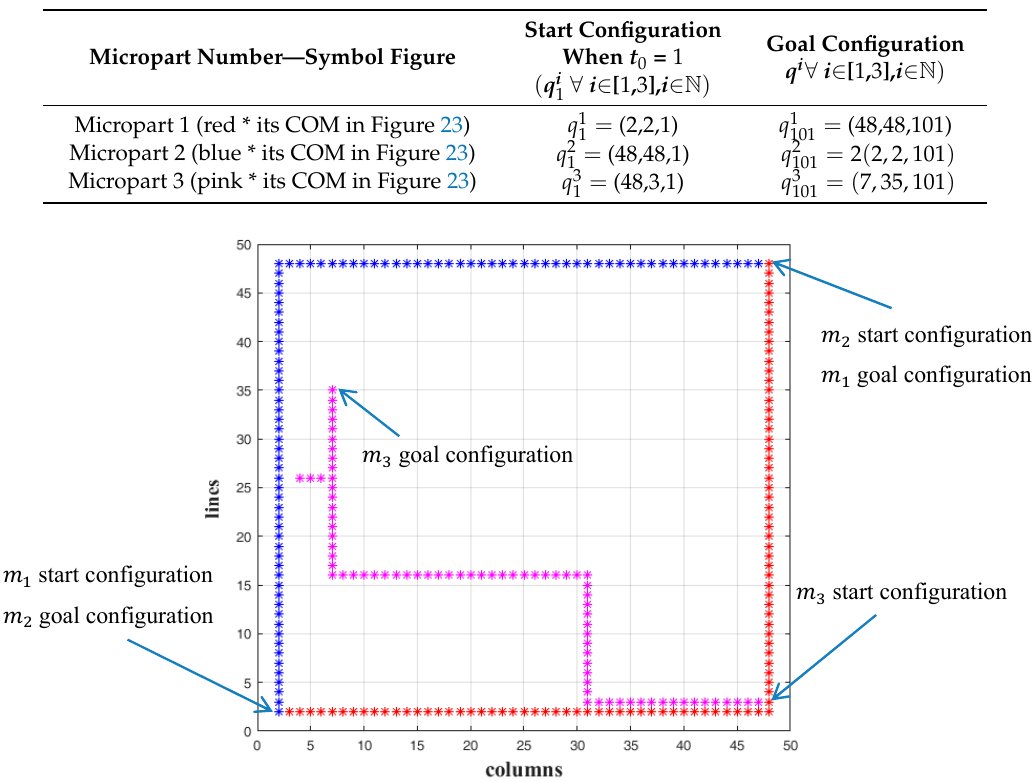
Figure 23. The 2D representation of the path computation of the three microparts with the computations of Equation (13).